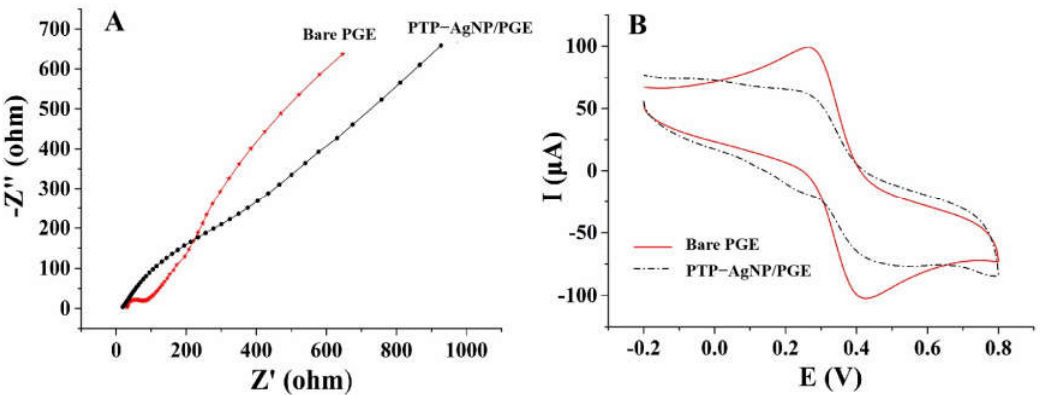
Figure 4. Electrochemical impedance spectroscopy ( A ) and cyclic voltammograms ( B ) of different electrodes in 5 mM Fe (CN) 63−/4− and 1 M KCl solution.